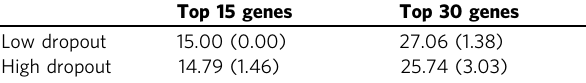
Table 2 The performance of EDGE in detecting the feature genes in simulated studies with two cell types over 100 replications. The standard deviation of the number of identi fi ed true feature genes is shown in the